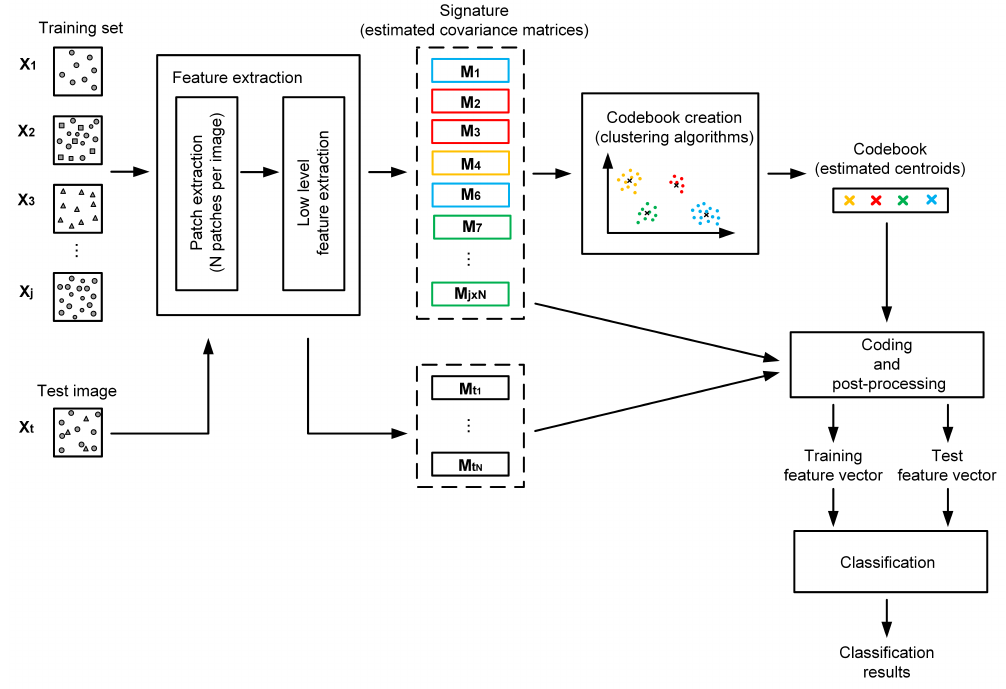
Figure 1. Workflow presenting the general idea of feature coding-based classification